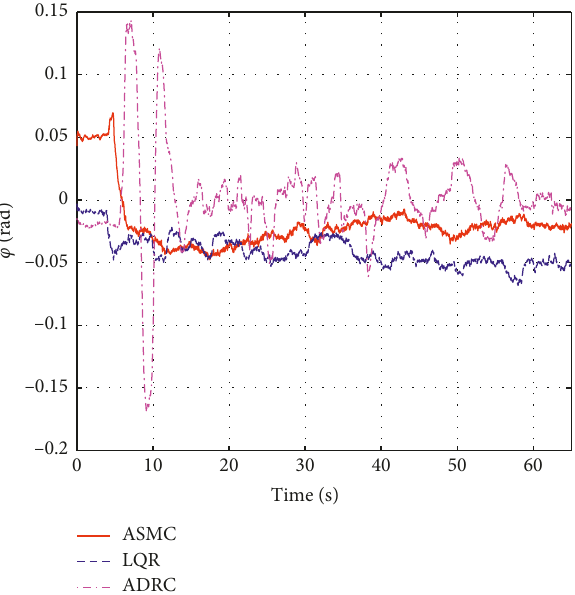
Figure 13: Tracking results of roll angle under the wind speed of 2.8 m/s.